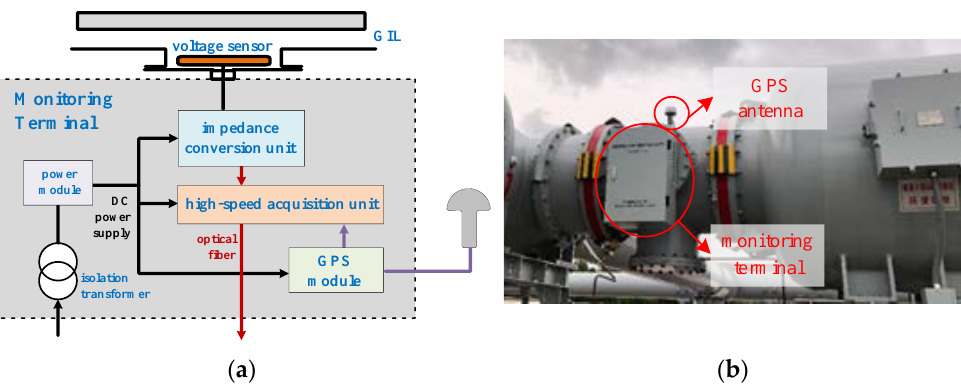
Figure 3. Monitoring terminal. ( a ) Structure of the monitoring terminal; ( b ) Entity of monitoring terminal and its installation position.